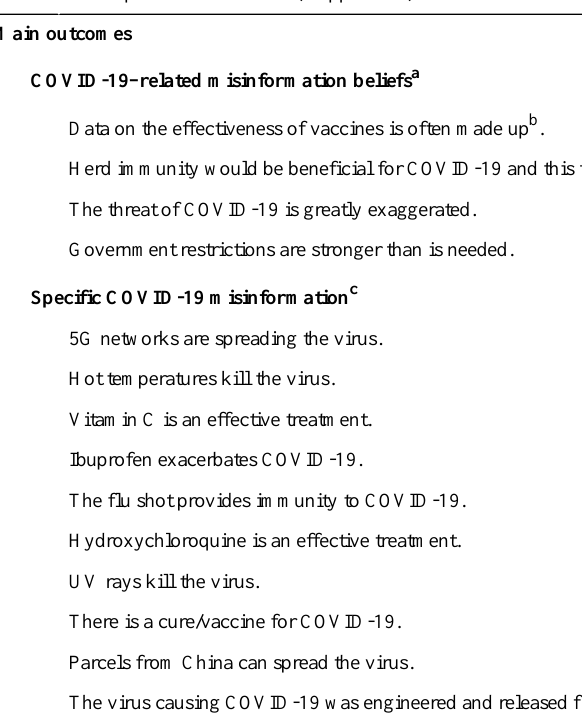
Table 1. Measures evaluated in this study. JuneMayAprilDescription and reference (if